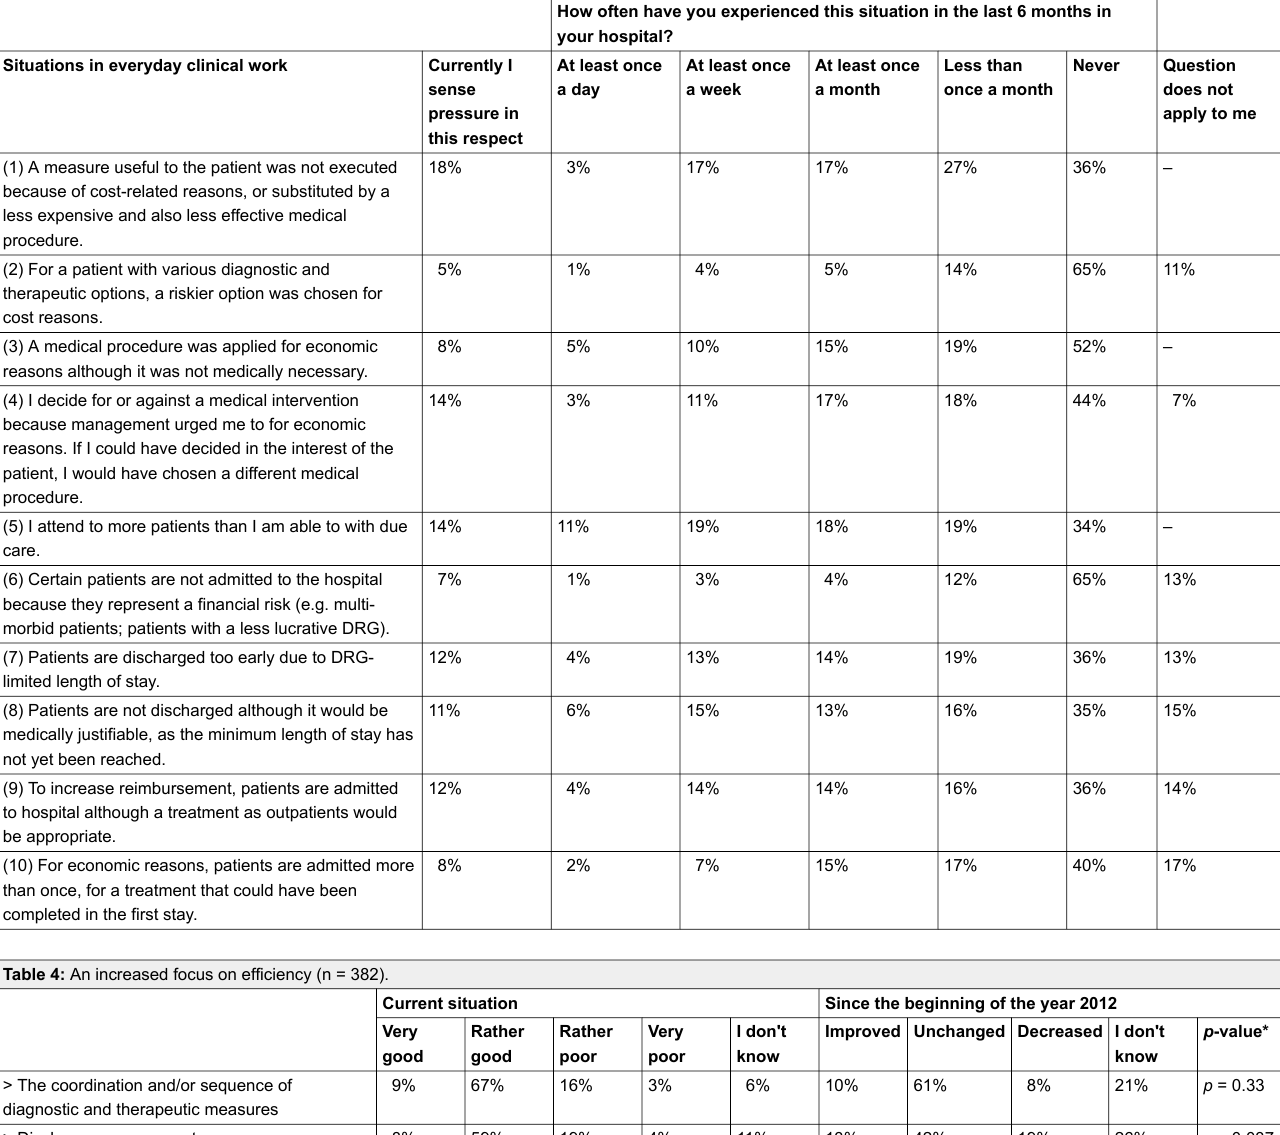
Table 3: Economic pressure in everyday clinical work (n = 382).